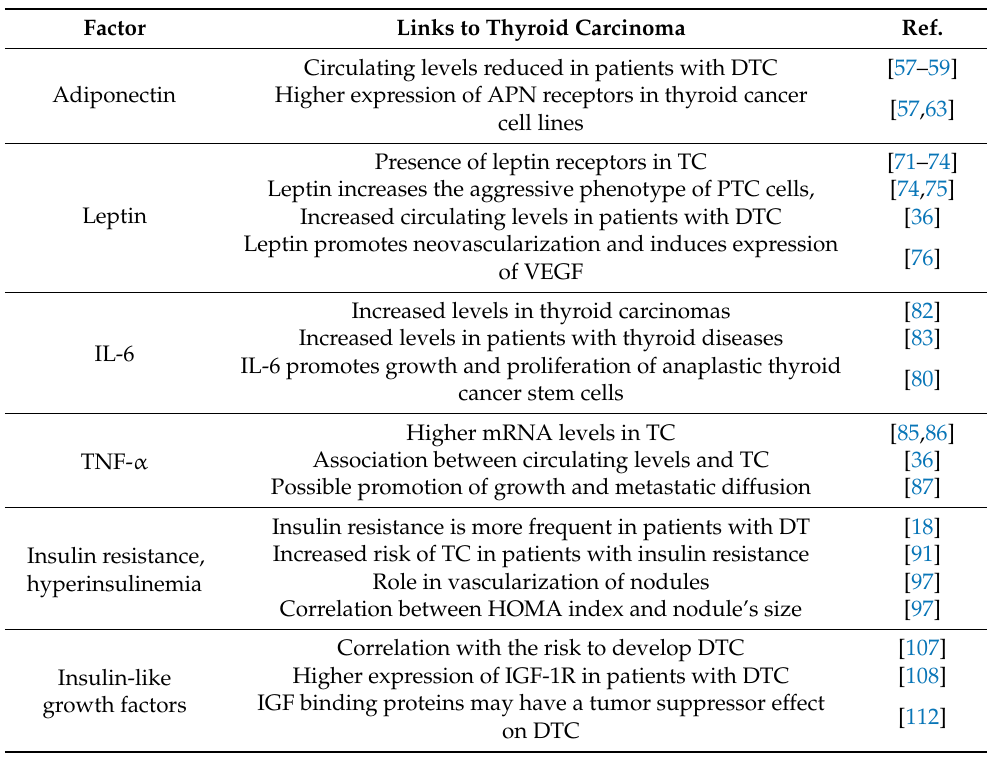
Table 1. Factors that may mediate the obesity effects on thyroid